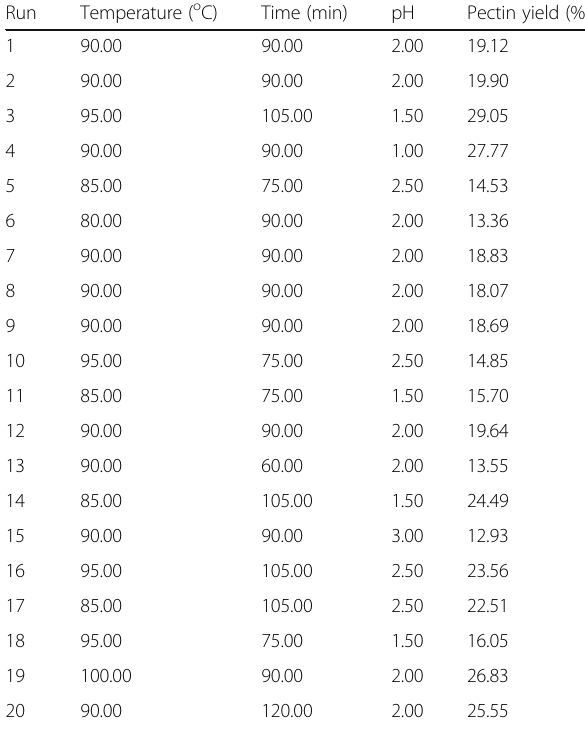
Table 2 Pectin yield at various processing conditions